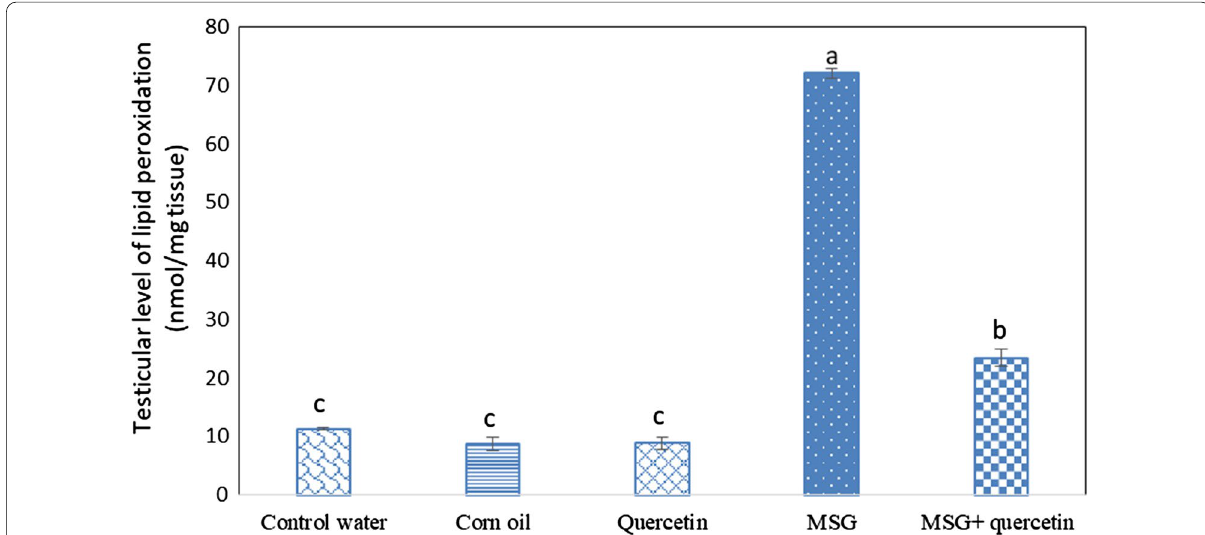
Fig. 1 Changes in the level of lipid peroxidation (nanomole per milligram tissue) in testis among all tested groups. The number of samples in each group is six. Values were expressed as mean standard error. Means which share different superscript symbol(s) are significantly different at ± P < 0.001